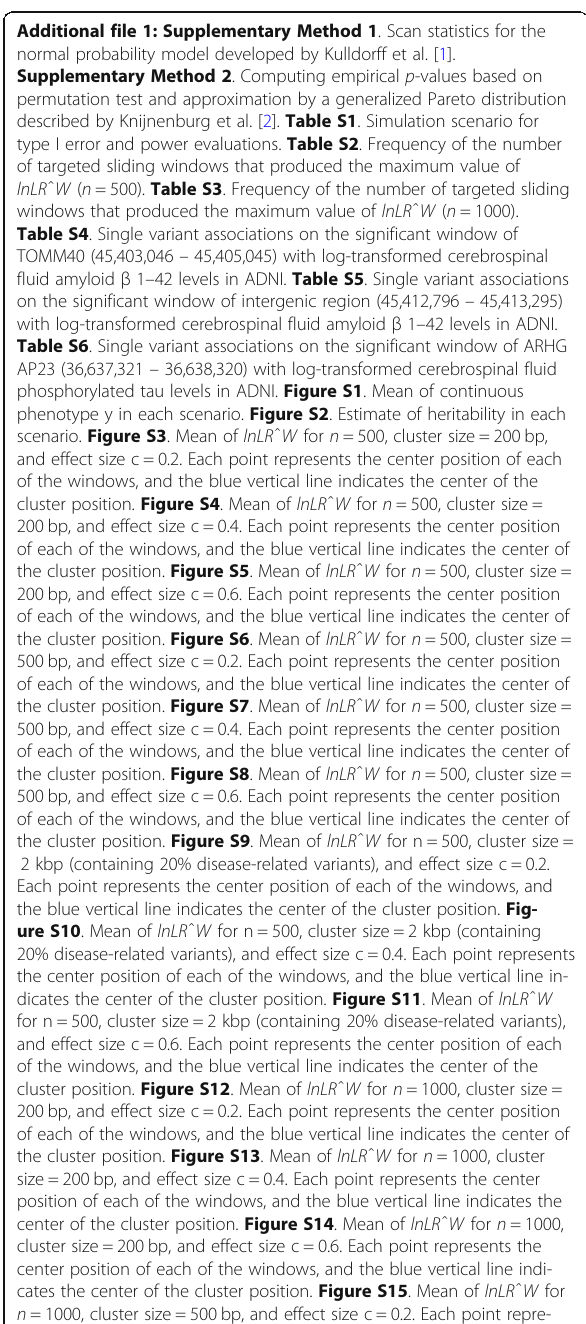
Table S6 . Single variant associations on the significant window of ARHG AP23 (36,637,321 – 36,638,320) with log-transformed cerebrospinal fluid phosphorylated tau levels in ADNI. Figure S1 . Mean of continuous phenotype y in each scenario. Figure S2 . Estimate of heritability in each scenario. Figure S3 . Mean of lnLR ̂ W for n = 500, cluster size= 200 bp, and effect size c= 0.2. Each point represents the center position of each of the windows, and the blue vertical line indicates the center of the cluster position. Figure S4 . Mean of lnLR ̂ W for n = 500, cluster size = 200bp, and effect size c= 0.4. Each point represents the center position of each of the windows, and the blue vertical line indicates the center of the cluster position. Figure S5 . Mean of lnLR ̂ W for n = 500, cluster size = 200bp, and effect size c= 0.6. Each point represents the center position of each of the windows, and the blue vertical line indicates the center of the cluster position. Figure S6 . Mean of lnLR ̂ W for n = 500, cluster size = 500bp, and effect size c= 0.2. Each point represents the center position of each of the windows, and the blue vertical line indicates the center of the cluster position. Figure S7 . Mean of lnLR ̂ W for n = 500, cluster size = 500bp, and effect size c= 0.4. Each point represents the center position of each of the windows, and the blue vertical line indicates the center of the cluster position. Figure S8 . Mean of lnLR ̂ W for n = 500, cluster size = 500bp, and effect size c= 0.6. Each point represents the center position of each of the windows, and the blue vertical line indicates the center of the cluster position. Figure S9 . Mean of lnLR ̂ W for n= 500, cluster size = 2 kbp (containing 20% disease-related variants), and effect size c= 0.2. Each point represents the center position of each of the windows, and the blue vertical line indicates the center of the cluster position. Fig- ure S10 . Mean of lnLR ̂ W for n= 500, cluster size =2 kbp (containing 20% disease-related variants), and effect size c= 0.4. Each point represents the center position of each of the windows, and the blue vertical line in- dicates the center of the cluster position. Figure S11 . Mean of lnLR ̂ W for n= 500, cluster size =2 kbp (containing 20% disease-related variants), and effect size c= 0.6. Each point represents the center position of each of the windows, and the blue vertical line indicates the center of the cluster position. Figure S12 . Mean of lnLR ̂ W for n = 1000, cluster size = 200bp, and effect size c= 0.2. Each point represents the center position of each of the windows, and the blue vertical line indicates the center of the cluster position. Figure S13 . Mean of lnLR ̂ W for n =1000, cluster size =200 bp, and effect size c= 0.4. Each point represents the center position of each of the windows, and the blue vertical line indicates the center of the cluster position. Figure S14 . Mean of lnLR ̂ W for n =1000, cluster size = 200bp, and effect size c= 0.6. Each point represents the center position of each of the windows, and the blue vertical line indi- cates the center of the cluster position. Figure S15 . Mean of lnLR ̂ W for n = 1000, cluster size = 500 bp, and effect size c= 0.2. Each point